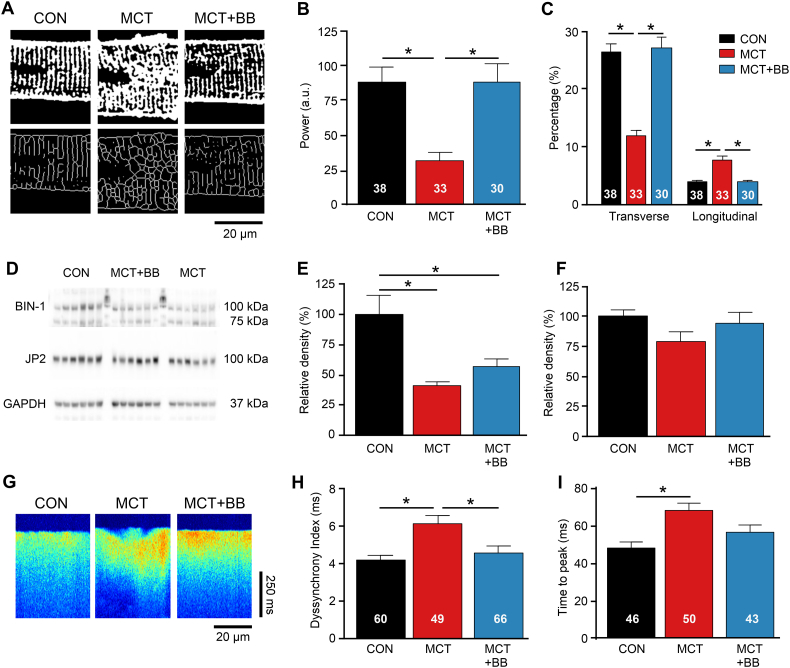
T-tubular structure was preserved and SR Ca2+ released synchronised by BB. A Binary images of t-tubule morphology (top) and following skeletonization (bottom). B The regularity of t-tubules (fast Fourier transform power) was reduced in MCT compared to CON but preserved by BB treatment. Myocyte number given in the fig. C Tubule orientation was mainly transverse in CON and MCT + BB myocytes but more longitudinal in MCT myocytes. D Representative Western blots of BIN-1, JP2 and GAPDH. Note difference in group orders between blots and data, protein ladders separate group samples for BIN-1. E Protein levels of BIN-1 were reduced in MCT and MCT + BB. F JP2 was not different between groups. G Confocal linescan recordings show spatial non-uniformities in Ca2+ transients from MCT cells. H Ca2+ release was more heterogeneous in MCT cells. I Mean time to peak Ca2+ was slower in MCT. B,C, N = 3–4 rats per group, E,F N = 6 rats per group, H,I,N = 5–8 rats per group. B,C,F,H,I one-way ANOVA, E non-parametric ANOVA. *P < .05.